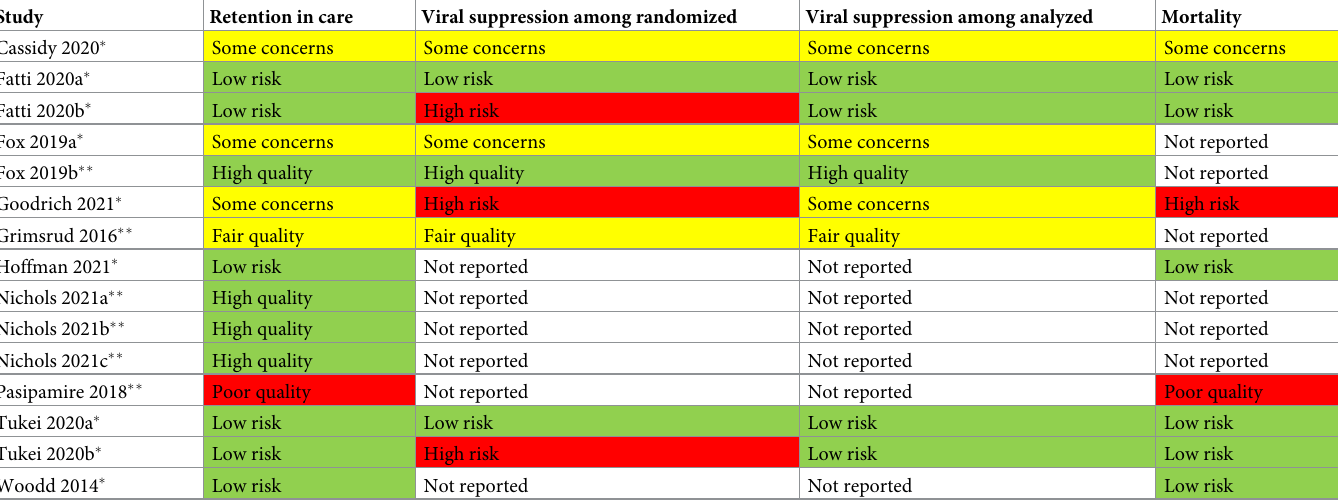
Table 4. Summary of risk of bias assessment.